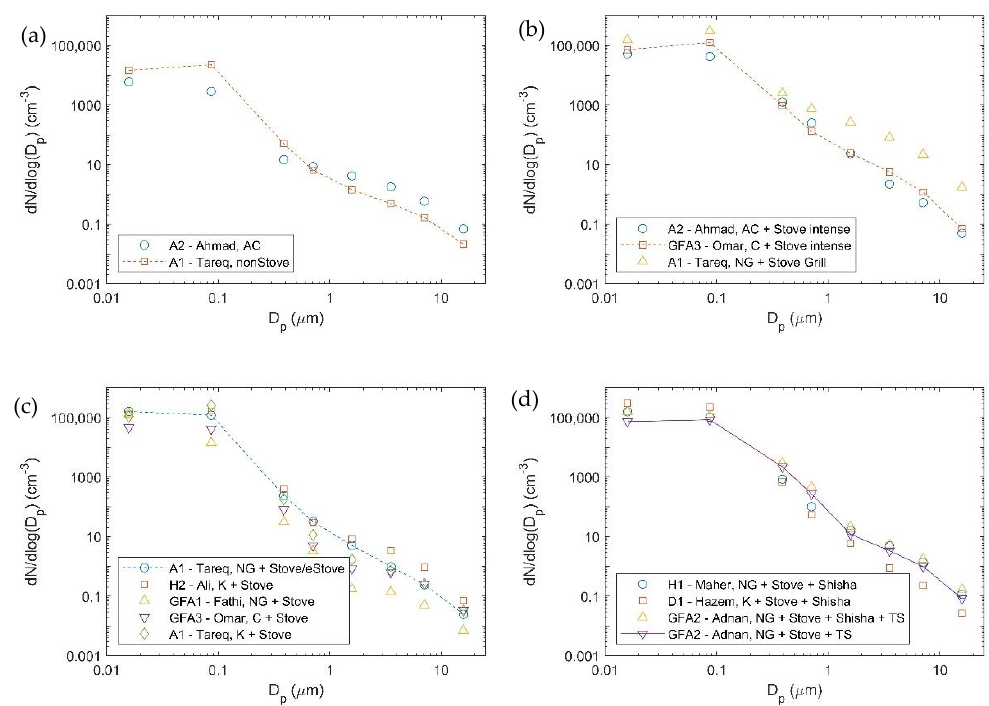
Figure 4. Mean particle number size distributions during selected indoor activities categorized by activity type: ( a ) Type I (non-combustion), ( b ) TYPE II (intensive cooking with different heating types), ( c ) TYPE III (combustion: heating and cooking), and ( d ) TYPE IV (combustion: heating, cooking, and smoking). Heating type: natural gas heater (NG), kerosene heater (K), central heating system (C), and air conditioning split unit (AC). Smoking type: shisha (SH) and tobacco smoking (TS). Cooking was reported on either a stove (natural gas) or using non-combustion appliances (i.e., water jug heater, microwave, etc.); the cooking intensity was indicated. The legend refers to the home ID and indoor activities.